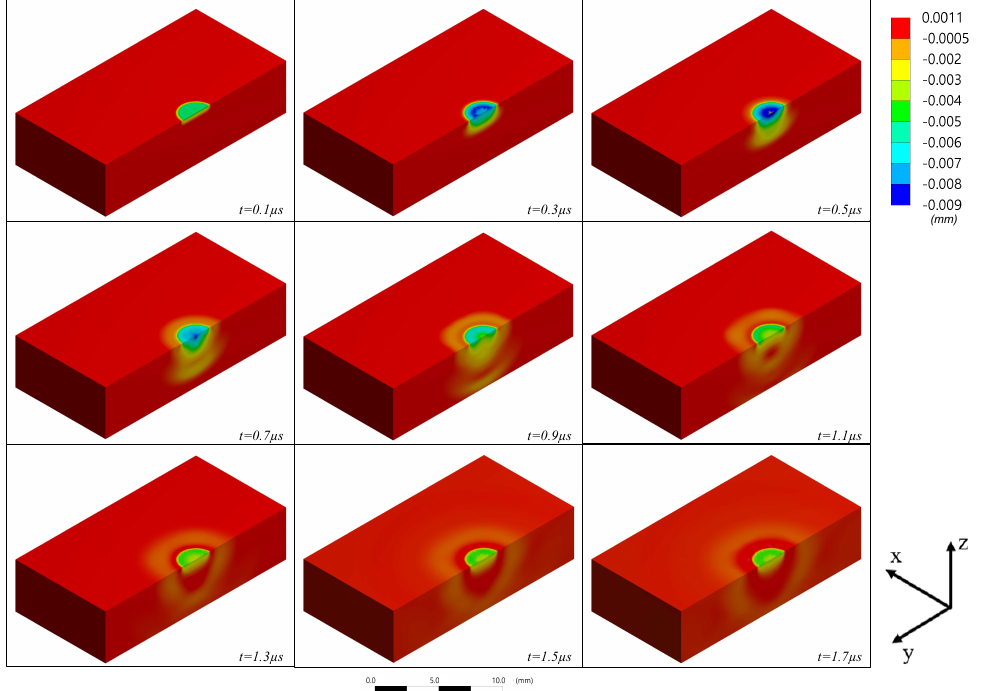
Figure 8. Transient analysis of the z-directional deformation in single